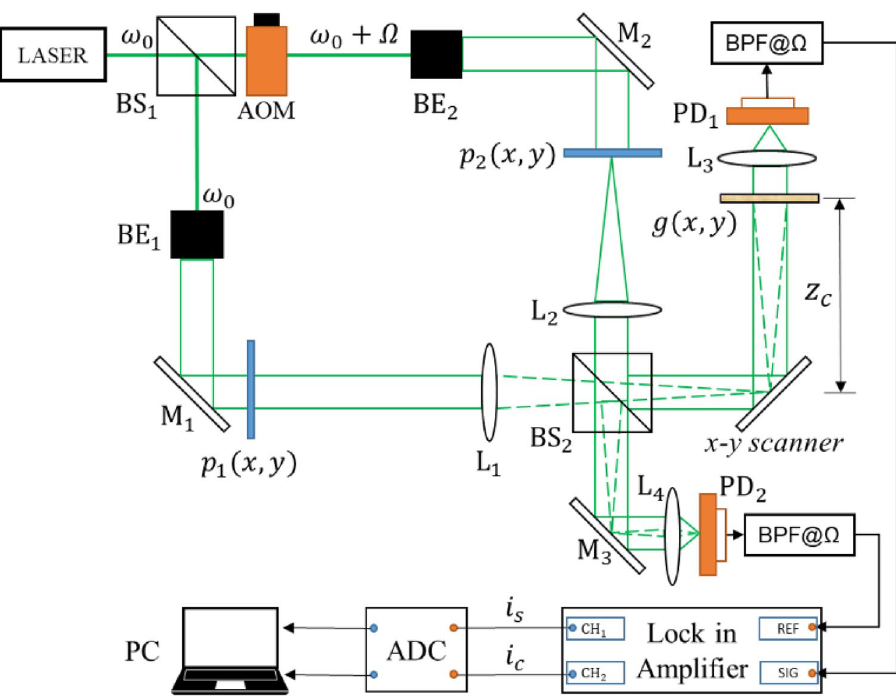
Figure 1. Architecture of the optical scanning cryptosystem. BS 1 and BS 2 : beam splitters; AOM: acousto-optical modulator;